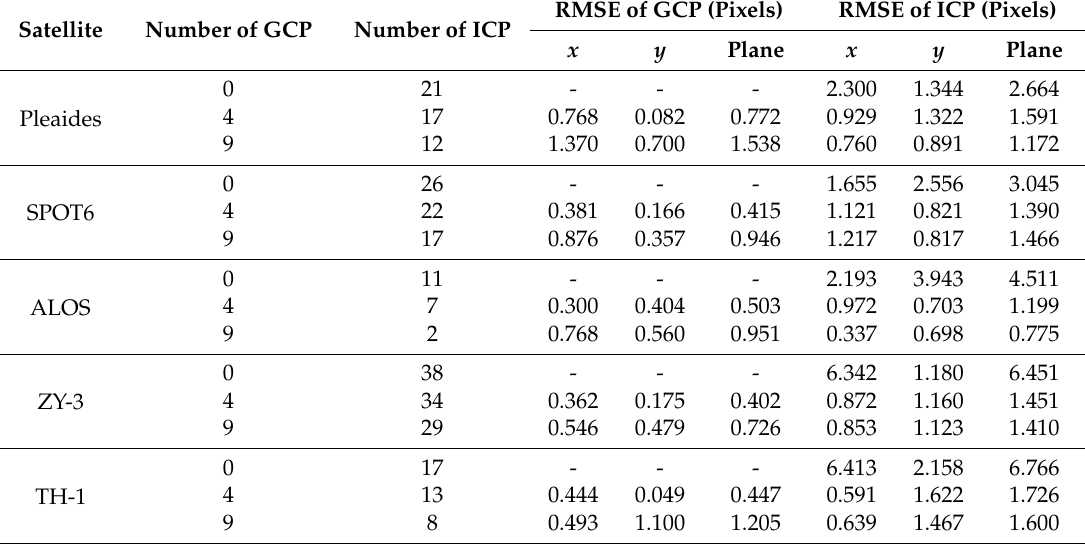
Table 3. Orientation accuracy of HRSIs.